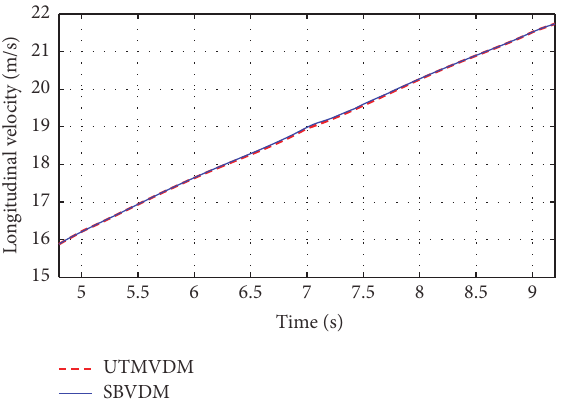
Figure 16: Yaw rate for sinusoidal steering test.